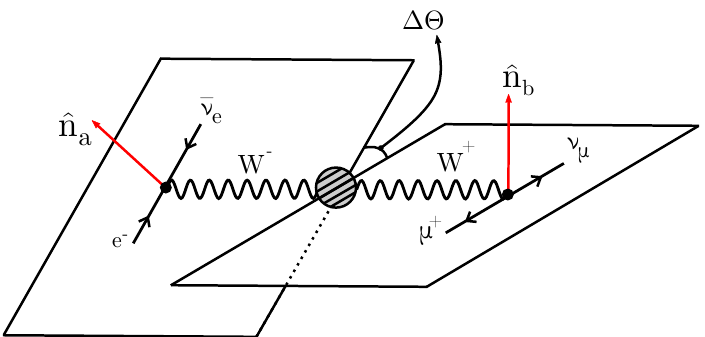
Figure 7. Schematic representation of the new angles for the variables cos(∆ θ ) and cos(∆ φ ) . The vectors ˆ n and ˆ n are normal to the plane formed by the decay products of W − and W + . We a b can use these vectors to determine the angle ∆ θ . Note that ν should be solely regarded as two e,µ distinct MET vectors, say ~E miss and ~E miss , corresponding to inactive cells in the vicinity of a T (1) T (2) charged lepton as explained in the three paragraphs before of section